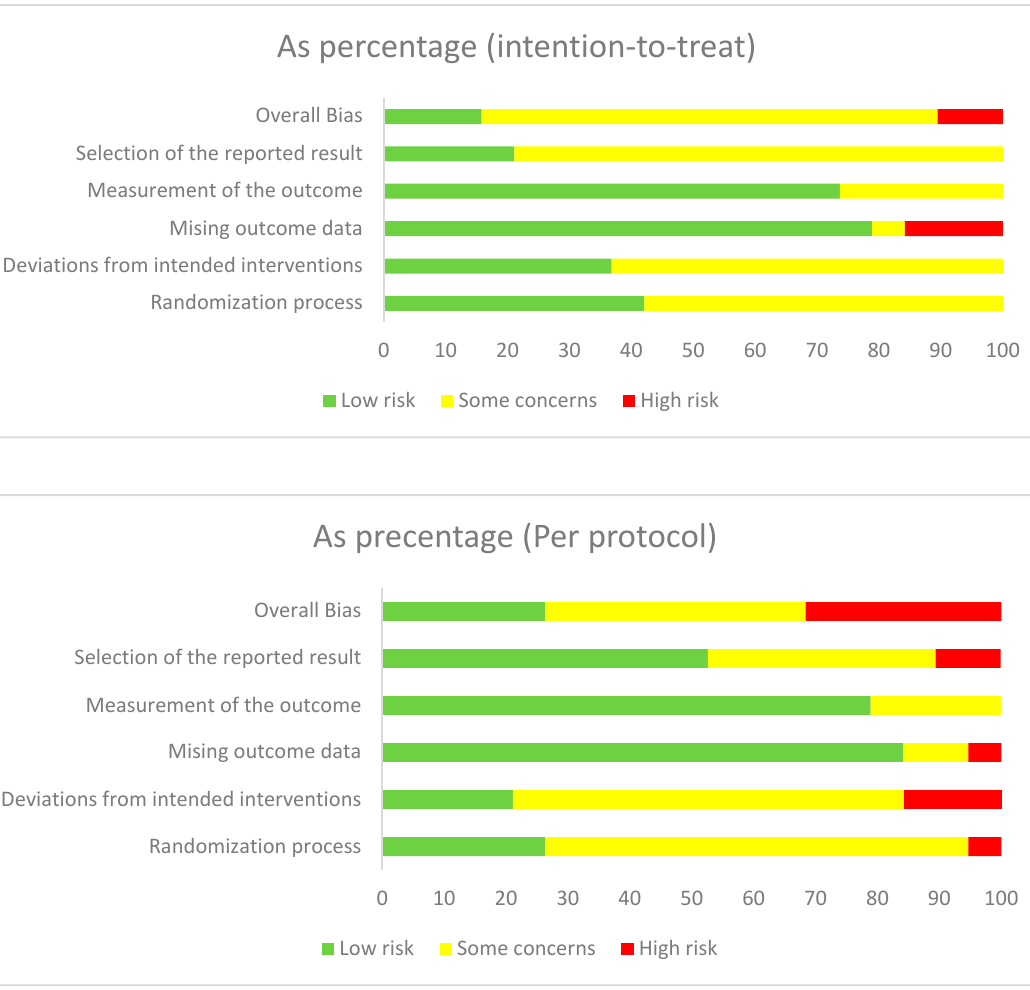
Figure 4. Nutrients 2020 , 12 , x FOR PEER REVIEW